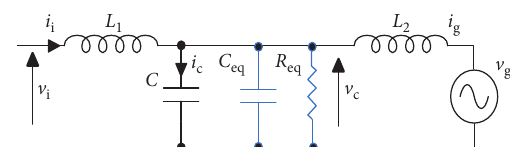
Figure 7: Equivalent circuit of the virtual